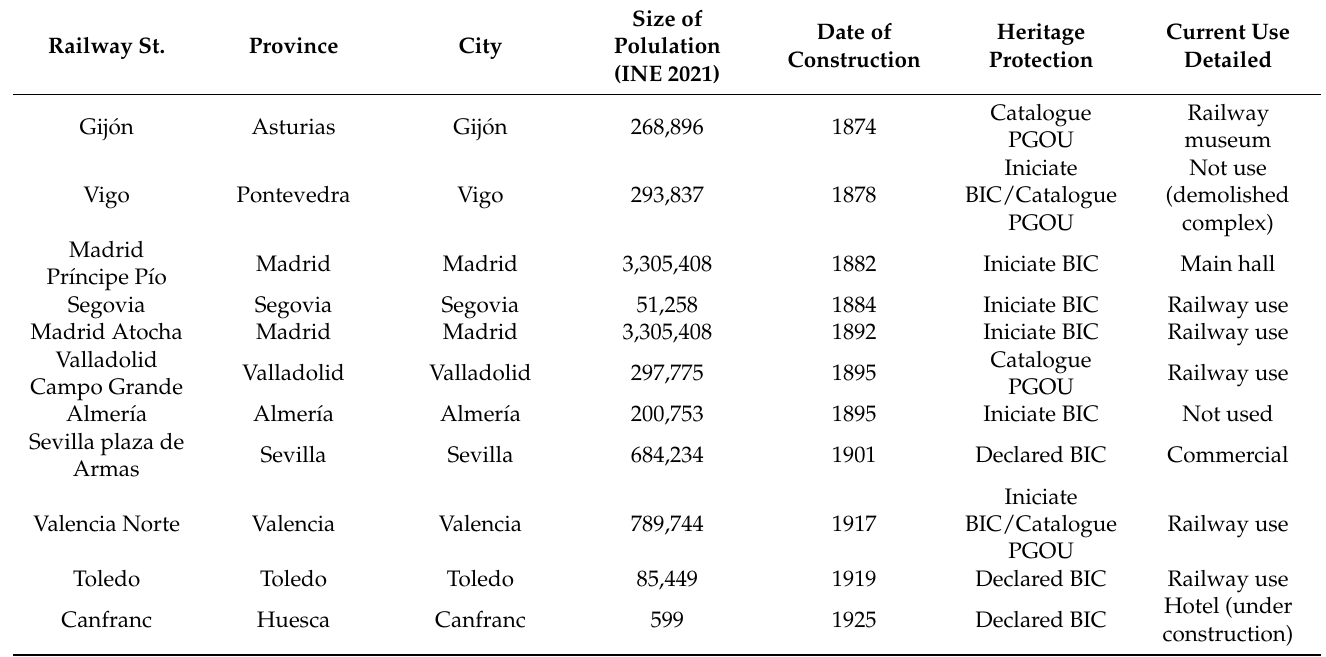
Table 1. Selected stations. Basic characteristics. Own elaboration.